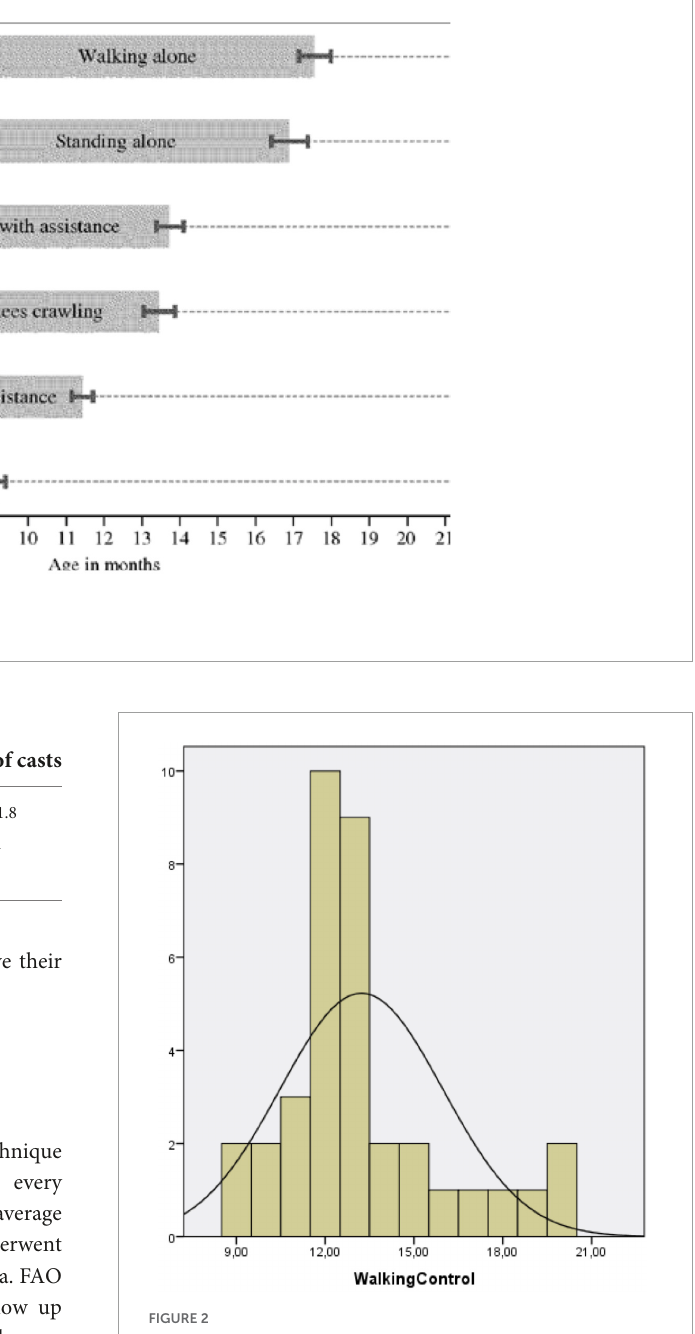
FIGURE2 WHO motor development study: windows of achievement for six gross motor development